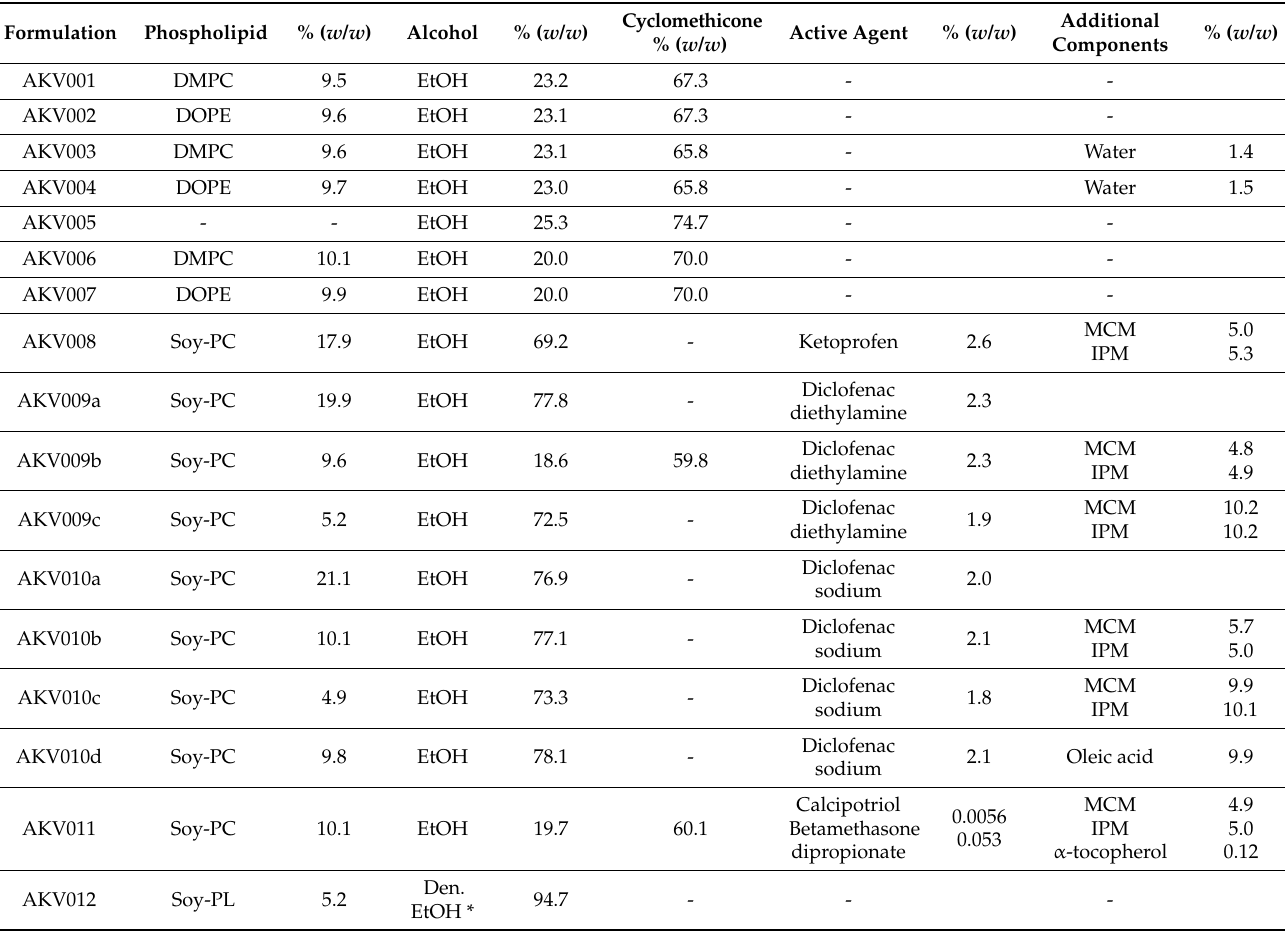
Table 1. Compositions used in the